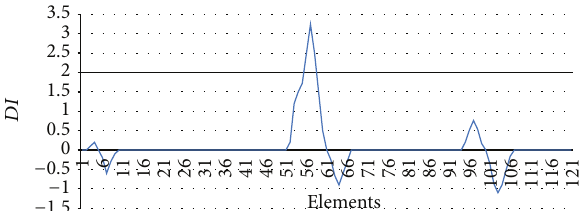
Figure 7: The DI of each element calculated by efficient